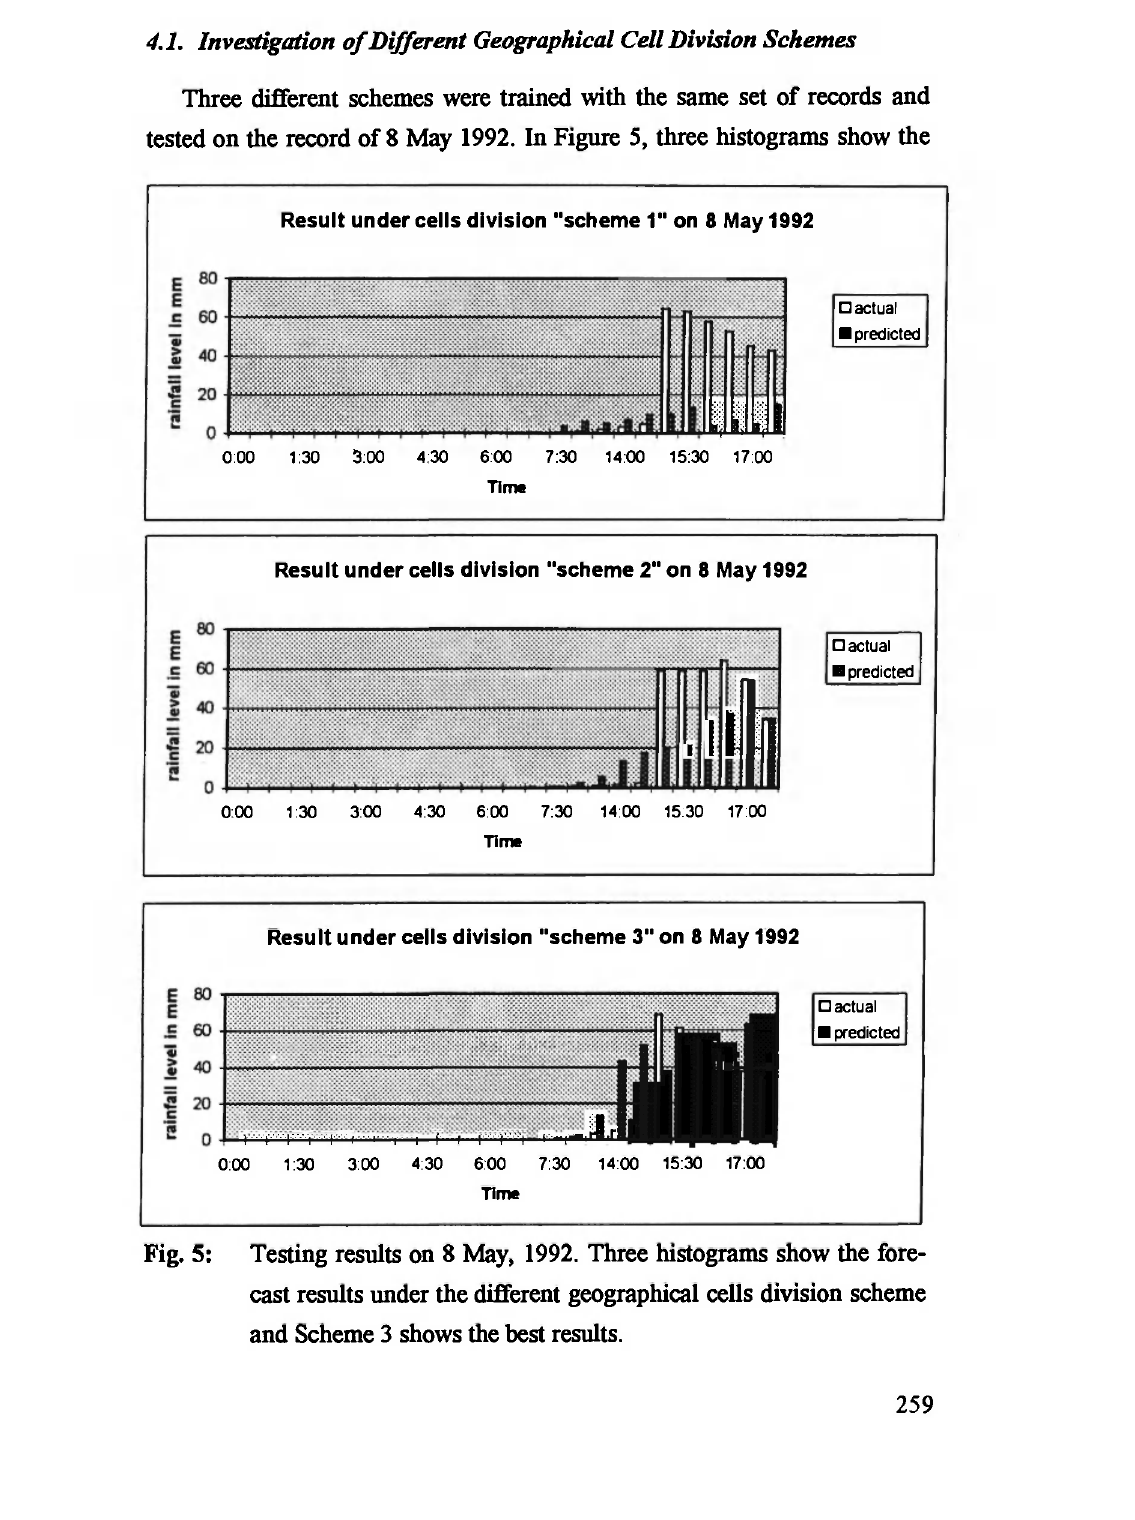
Fig. 5: Testing results on 8 May, 1992. Three histograms show the fore- cast results under the different geographical cells division scheme and Scheme 3 shows the best